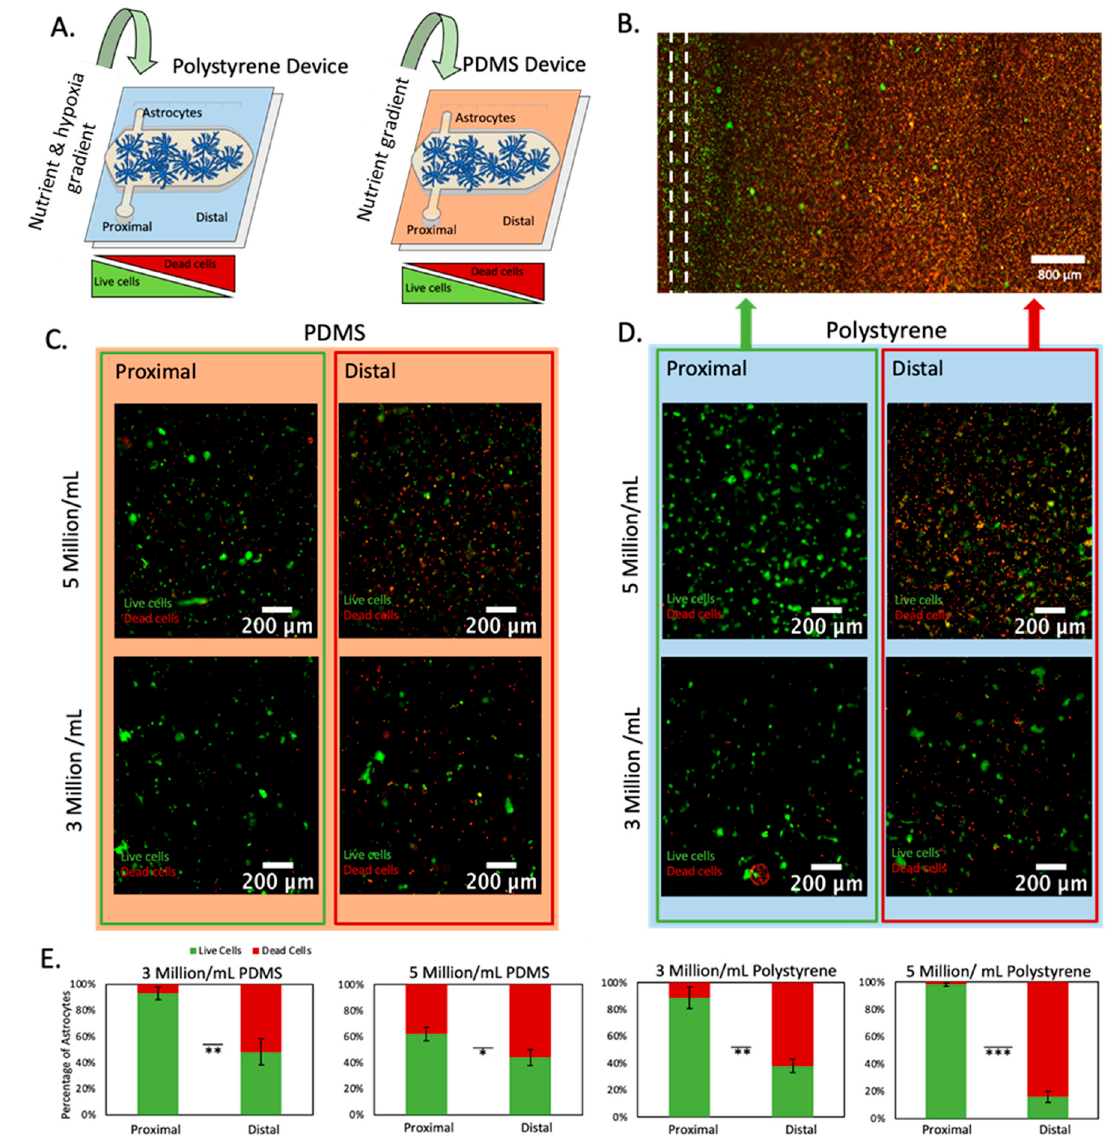
Figure 2. Cell viability analysis at varying densities within polystyrene and PDMS microfluidic devices. ( A ) Schematic representation of polystyrene and PDMS microfluidic devices. Both devices had one lumen located in the culture chamber flank, creating an asymmetric oxygen and nutrient distribution. Since PDMS is permeable to oxygen, only a gradient of nutrient is created in the PDMS-based microdevice. ( B ) Fluorescence microscopy image of astrocytes within polystyrene microfluidic device at 5 million cells/mL. Live and dead cells are shown in green and red, respectively. The location of the lumen is shown in a dashed line. ( C ) Astrocytes within PDMS microfluidic devices at varying densities imaged at lumen and necrotic core. Red and blue backgrounds are used to denote results obtained in polystyrene and PDMS devices respectively. Green and red outlines are used to denote results obtained from the proximal and distal region respectively. ( D ) Astrocytes within polystyrene microfluidic devices at varying densities imaged at lumen and necrotic core. ( E ) Graphs depicting cellular viability of astrocytes at densities of 3 million/mL and 5 Million/mL within polystyrene and PDMS microfluidic devices. *, **, *** denote p-value < 0.05, 0.01, 0.005 respectively.